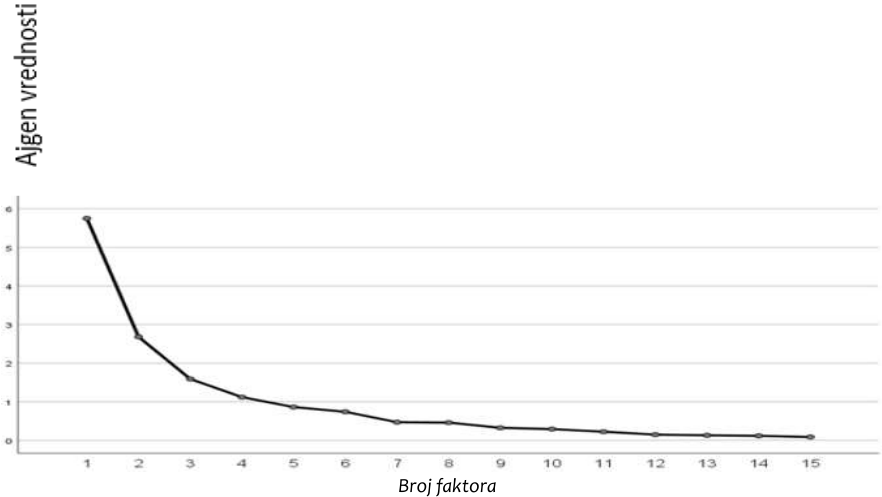
Sadrža j faktora prikazan je u Tabeli 3. Na osnovu strukture faktora prvi faktor je nazvan Hrišćanske vrednosti (HV) jer okuplja stavke koje ukazuju na važnost hrišćanskih vrednosti, porodičnog i duhovnog aspekta života, dok je drugi faktor nazvan Svetovne vrednosti (SV) jer okuplja četiri stavke koje su usmerene na važnost zdra vlja, te profesionalne i materijalne uspehe. Faktori nisu bili značajno korelirani (r = 0.00), a pouzdanosti merene Kronbahovim alfom koeficijentom su zadovoljavajuće u slučaju oba faktora (HV α = 0.90; SV α = 0.78). Т abela 3. Matrica sklopa stavki skale vrednosti Tvrdnje Kroz vrline stečene u hrišćanskom duhu, istrajavam na putu ličnog i moralnog uzrastanja i razvijanja potencijala. Vera u Boga mi pomaže da prevaziđem velika iskušenja ( bolest, razočarenje, neuspeh, siromaštvo) . Hrišćanska duhovnost mi pomaže da istrajem u učenju i radu . 0.79 Život ima smisla kada uradim i ostvarim ono što treba, prema hrišćanskoj duhovnosti, moralu i Božijim zapovestima .